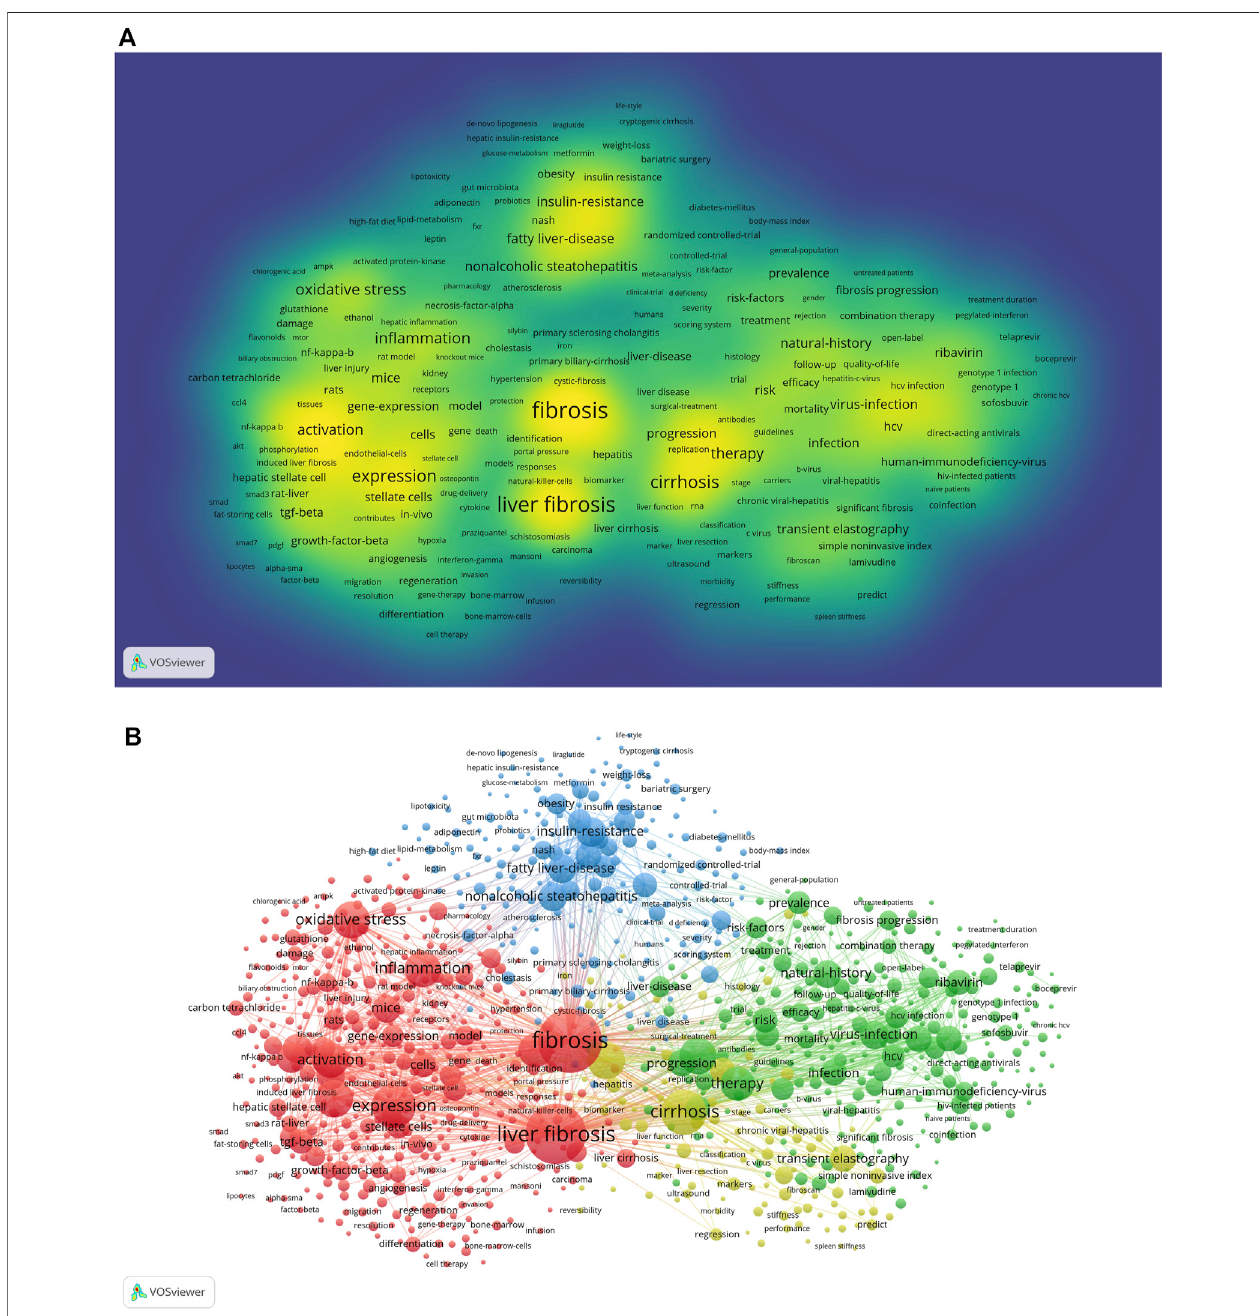
FIGURE 7 | Maps of keywords in the treatment of liver fi brosis (A) The density map; (B) Co-occurrence network and clusters. Notes: The size of word and round, and the opacity ofyellowarepositivelyassociatedwith theco-cited frequency (MapA). The sizeofthenodeand keyword indicates the co-occurrence frequencies while their different colors re fl ect different clusters, and the links re fl ect the co-occurrence relationship (Map B).jpg.